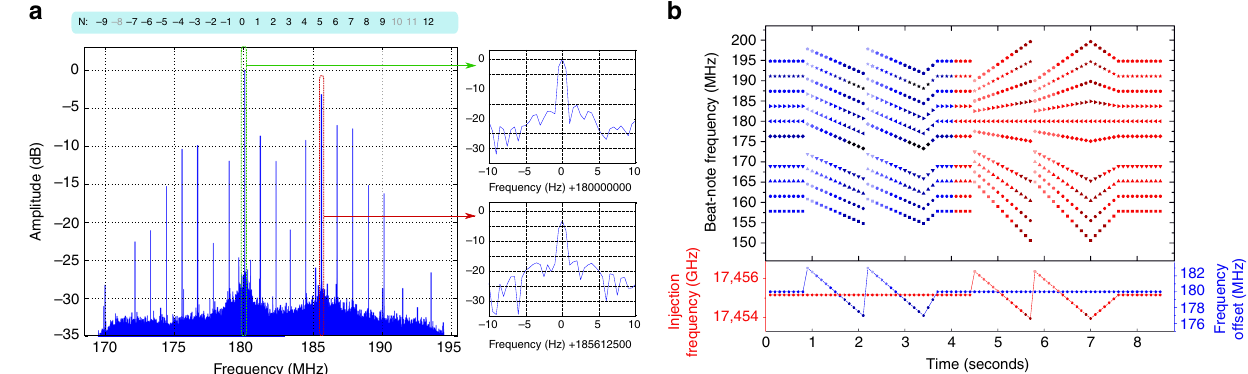
Fig. 3 High-resolution comb spectra and frequency tuning. a RF-comb spectrum measured with 0.5 Hz RBW, limited by the acquisition time of 2 s. Insets: zoom on two RBW-limited peaks. b Fine tuning of the QCL-comb frequencies. First, the f LO frequency of the PL-loop that stabilizes the comb-offset is tuned, in steps of 500 kHz, between 183 and 177 MHz. Then, the frequency of the injecting RF-signal ( f RF ) is tuned by 2.4 MHz, in steps of 200 kHz. Simultaneously, the RF-comb spectrum is acquired and the frequencies of individual modes are measured with a 100 Hz